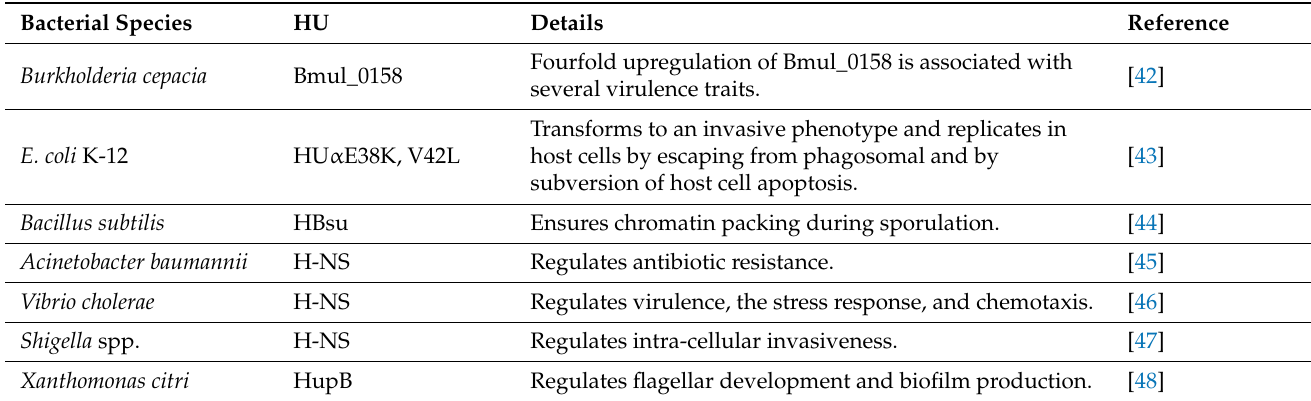
Figure 2. ( A ) Eukaryotic histones (green) have lysine-rich tails that are acetylated by lysine acetyl- transferases, and this result in a reduction in affinity of the histone for DNA; ( B ) the histone-like protein (HU) (blue) of Mycobacterium also has a tail that is rich in lysines, which is acetylated by Eis, leading to a reduction in DNA affinity; ( C ) other bacterial HUs do not have tails but are acetylated at other positions to reduce their affinity to DNA. Table 2. The epigenetic regulation of pathogenic effectors through HU proteins.